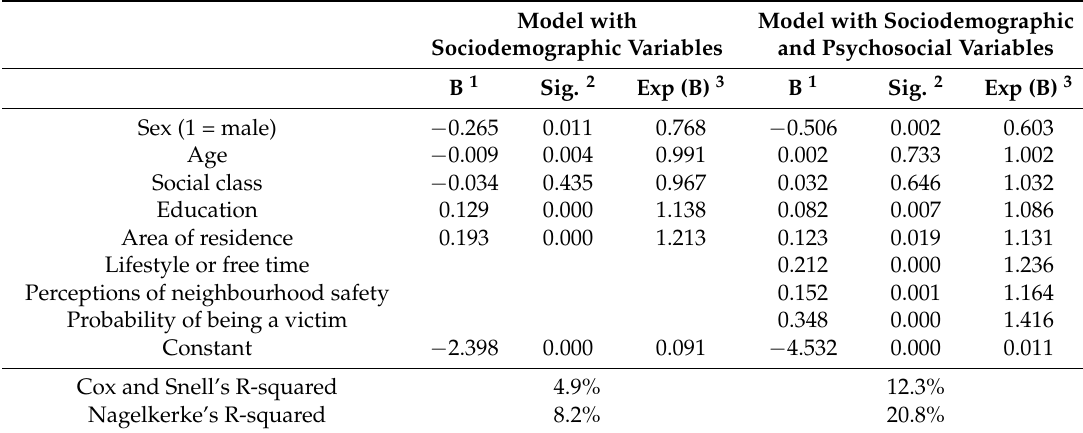
Table 5. Logistic regression analysis with “having been a victim or not” in the last 12 months, as the dependent variable (Spain,